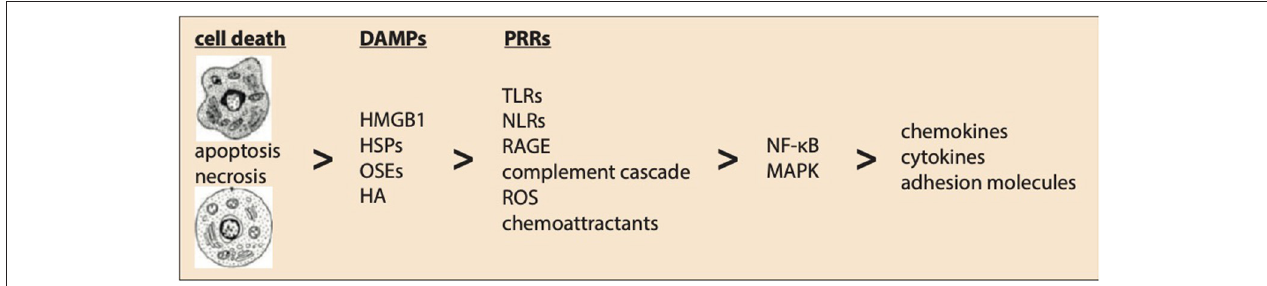
FIGURE 1 | Innate immunity following myocardial ischemia–reperfusion injury. Ischemic-induced myocardial cell death activates innate immunity. Expression of endogenous ligands upon reperfusion are known as danger-associated molecular patterns (DAMPs) including HMGB1, high-mobility group box-1; HSPs, heat shock proteins; OSEs, oxidation-specific epitopes; HA, hyaluronic acid. These DAMPs are recognized by pattern recognition receptors (PRRs) like TLRs, NLRs, RAGE, complement cascade, reactive oxygen species (ROS), and chemoattractants. Finally, activation of the nuclear factor (NF)- κ B and mitogen-activated protein kinase (MAPK) pathways induce the expression of pro-inflammatory chemokines, cytokines, and adhesion molecules regulating a complex post-ischemic inflammatory